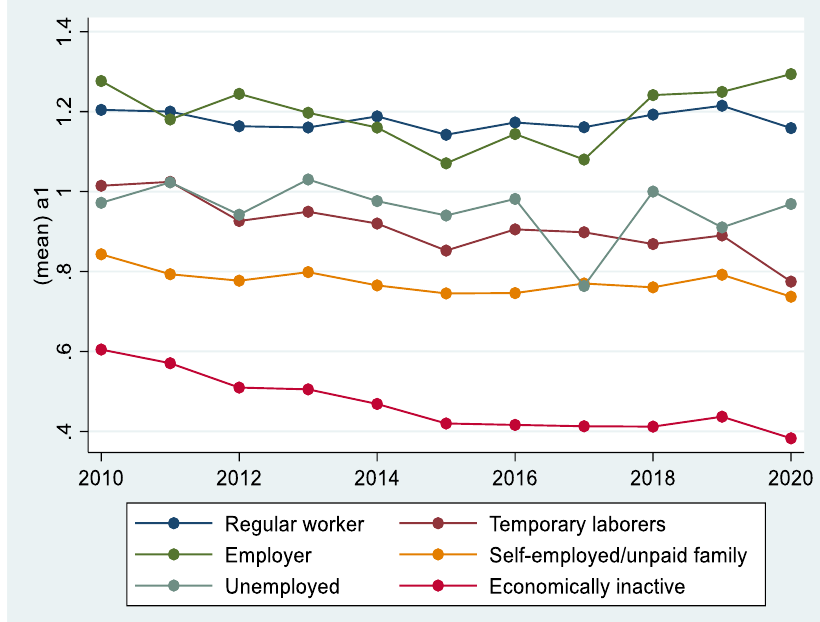
Figure 5. Drinking trends by occupation.